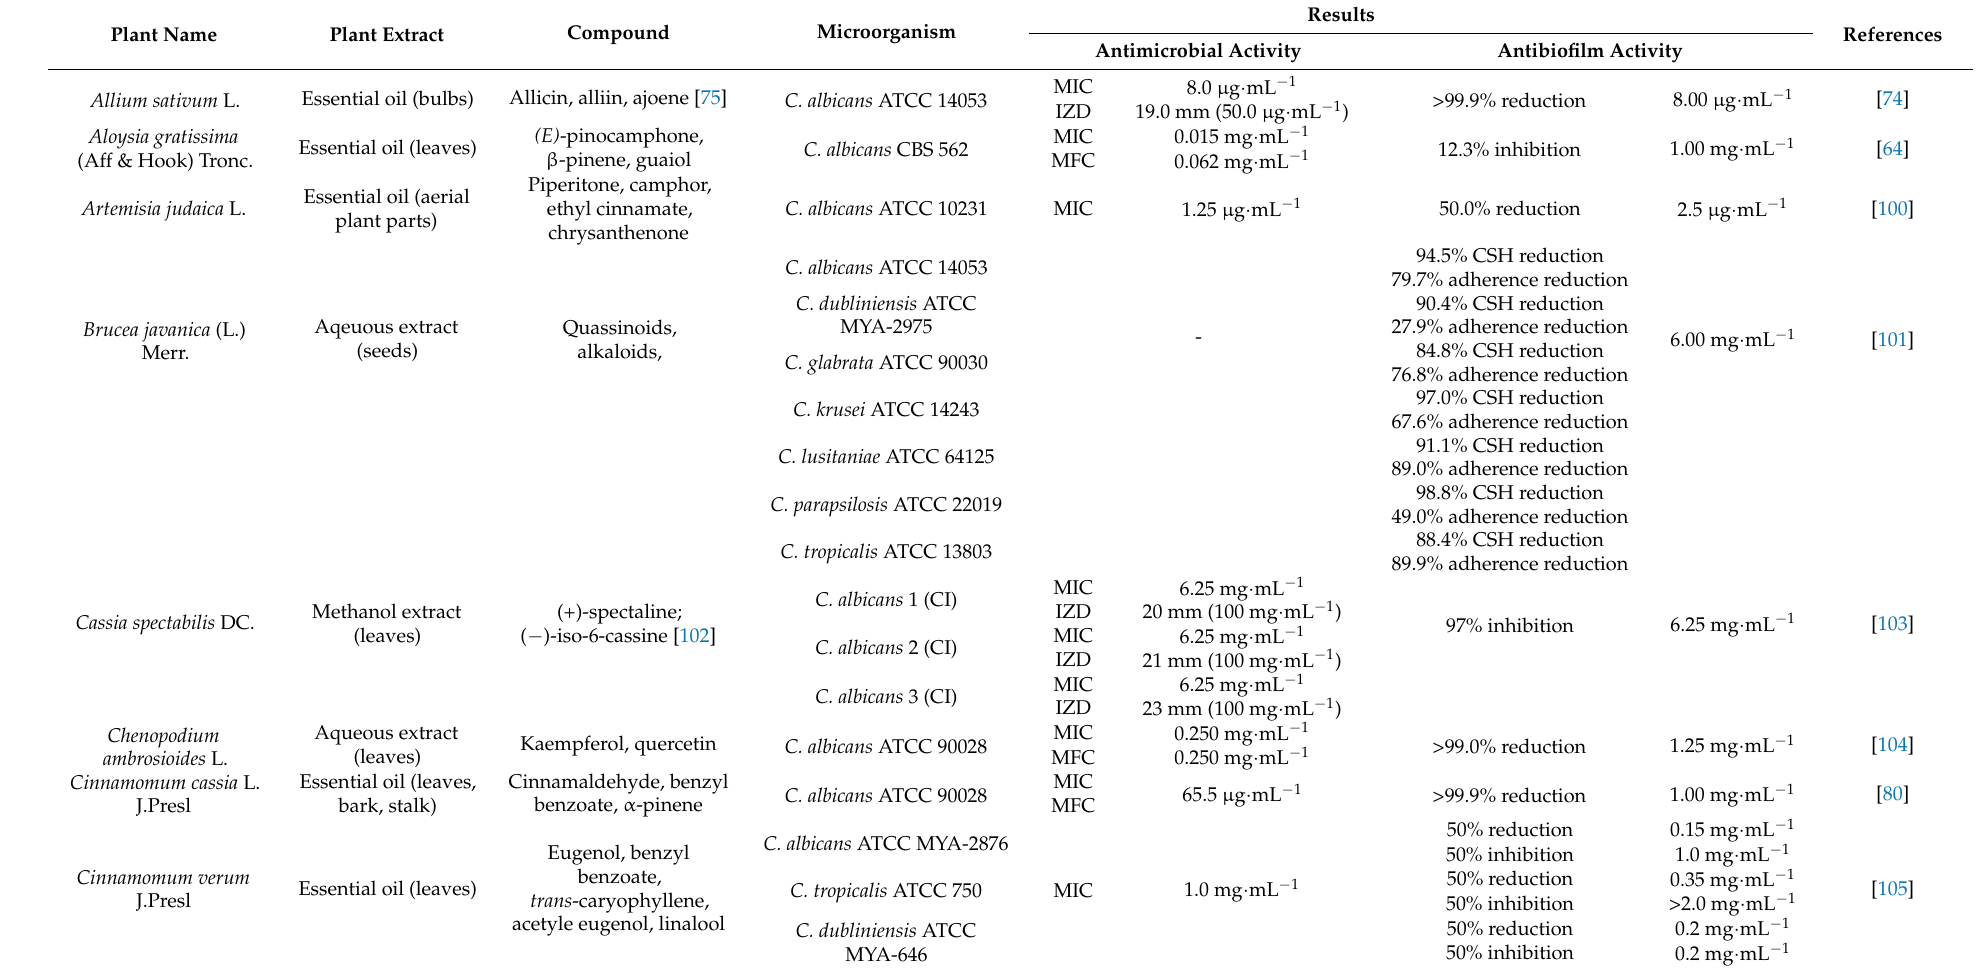
Table 1. Medicinal plants with antimicrobial/antibiofilm activity against oral Candida spp. and the respective bioactive compounds present in their